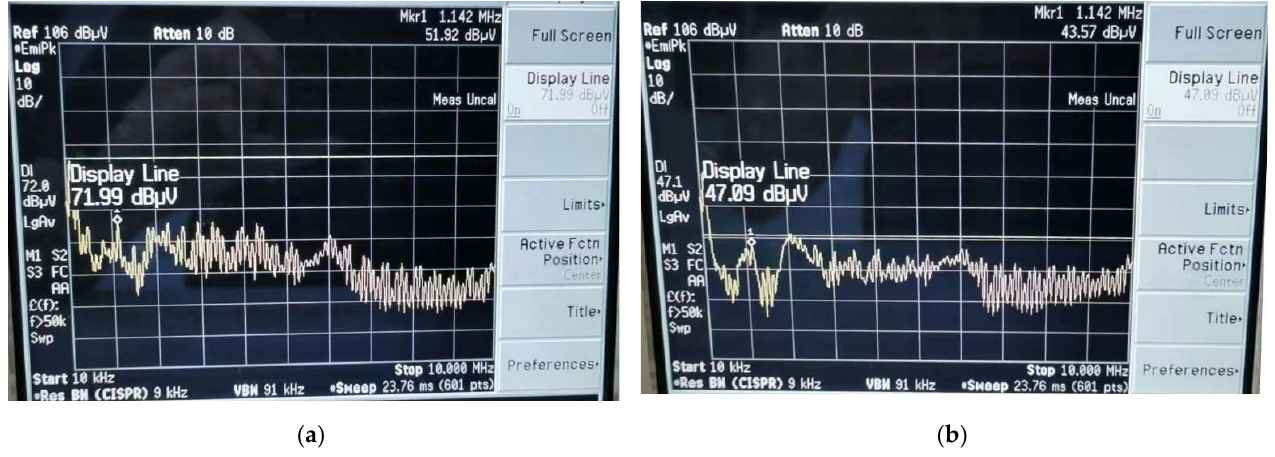
Figure 16. The test result of conducted emission in different switching conditions: ( a ) The two-stage converter in hard switching; ( b ) The two-stage converter in soft switching.